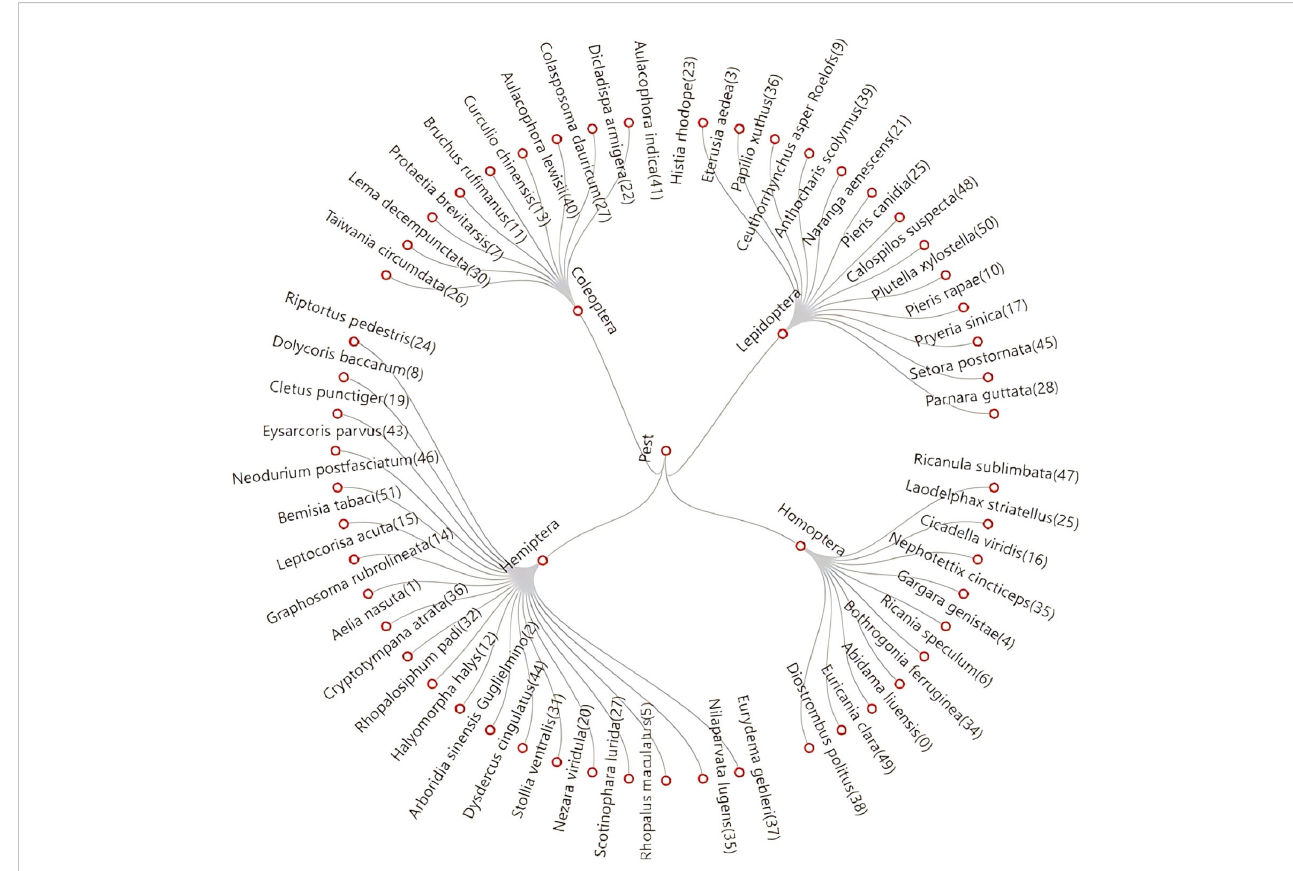
FIGURE 2 The hierarchical taxonomy of FSIP52 is explicitly strati fi ed into four superclasses, namely, Homoptera, Hemiptera, Lepidoptera, and Coleoptera and 52 subclasses that follow the division of the pest class family. The numbers in brackets after the name of each class of insects indicate the category ID in